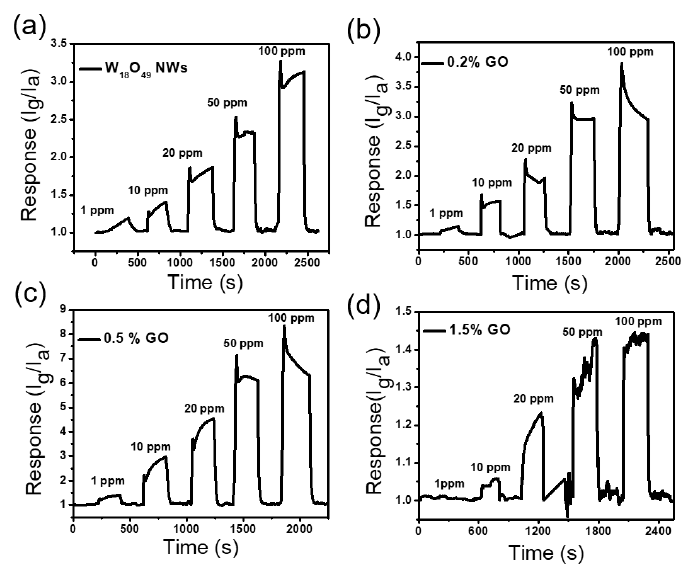
Figure 5. Gas sensing properties of various samples at 300 °C towards toluene vapors. ( a ) pure W 18 O 49 NWs, ( b ) 0.2 wt. % W 18 O 49 NWs/rGO composite, ( c ) 0.5 wt. % W 18 O 49 NWs/rGO composite, ( d ) 1.5 wt. % W 18 O 49 NWs/rGO composite.